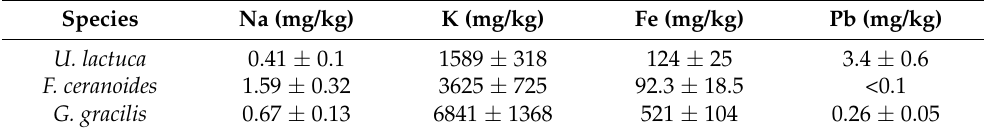
Table 2. The content of macro, trace elements and heavy metal ions in seaweed species (mg/kg, dry wt.). Species